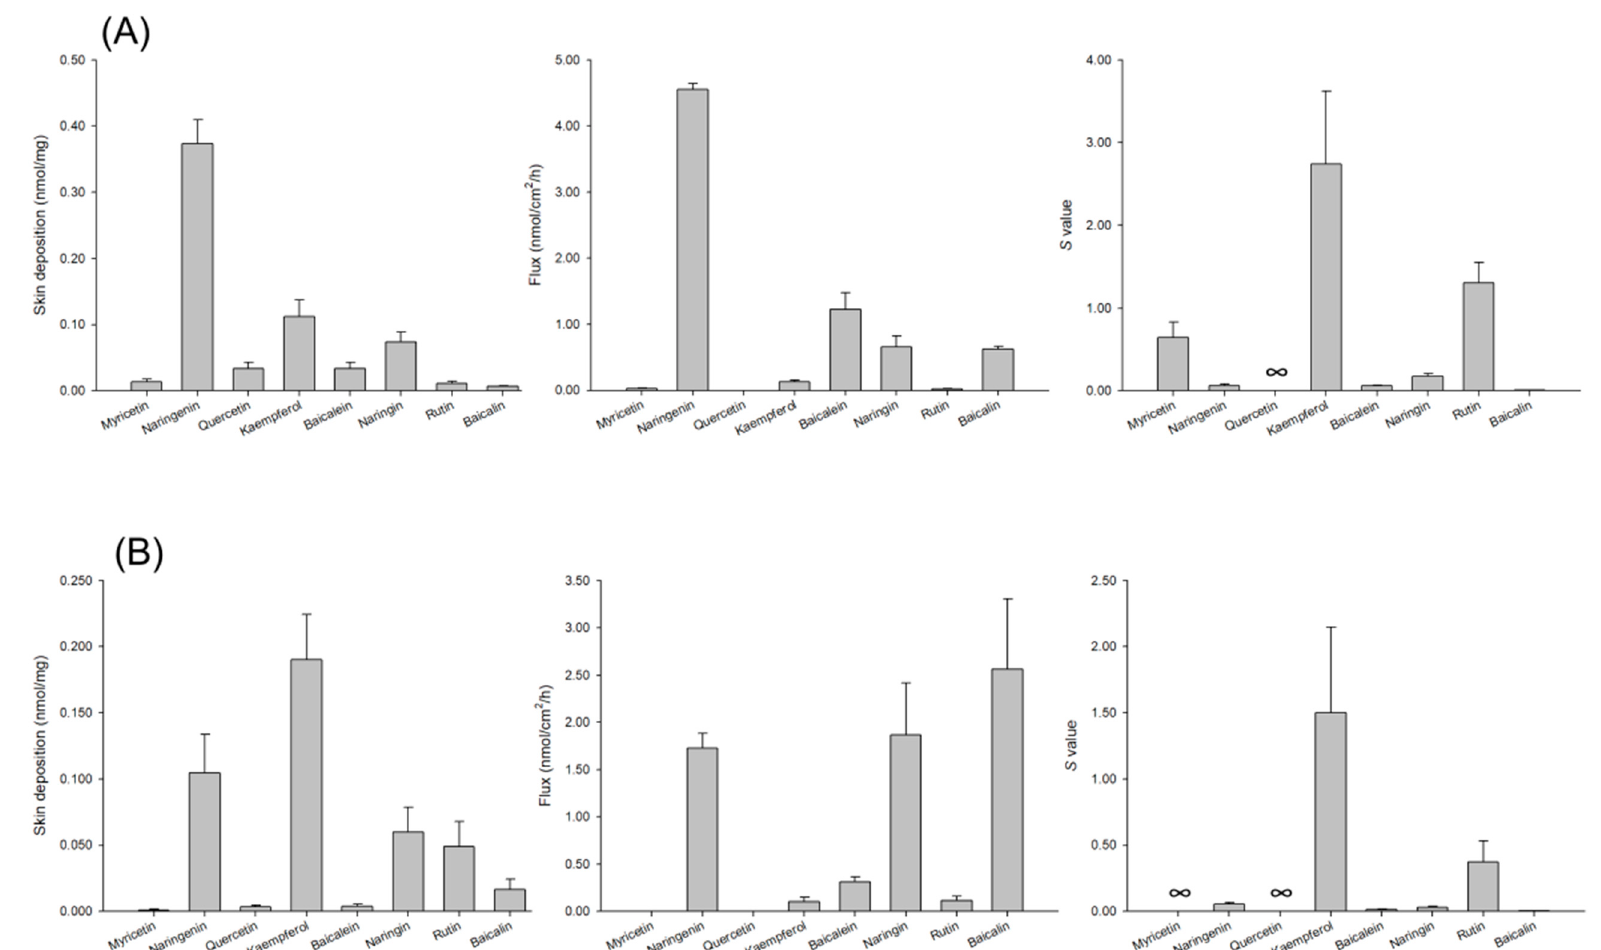
Figure 2. Skin deposition, flux, and S value of flavonoids at a dose of 6 mM after topical treatment on nude mouse and pig skins: ( A ) nude mouse skin; and ( B ) pig skin. The donor vehicle is 20% PEG400 in pH 7.4 buffer. All data are presented as the mean of four experiments ± S.D.